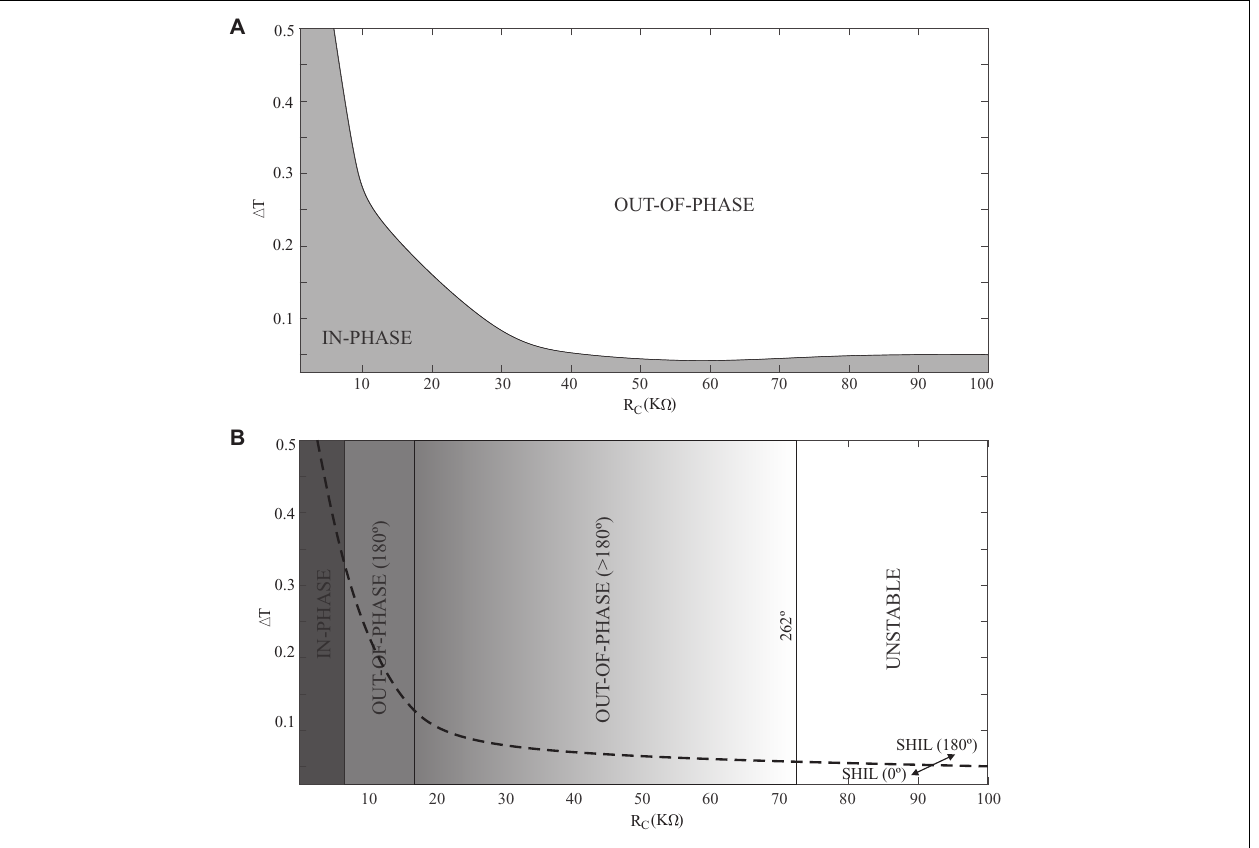
FIGURE 5 | (cid:49) T vs. R C plot for in-phase/out-of-phase operation of two conventional coupled oscillators. (A) Nominal scenario. (B) Considering R INS and R MET variations. The boundary for the in-phase/out-of-phase operation of two SHIL-based oscillators is depicted with a dashed line.